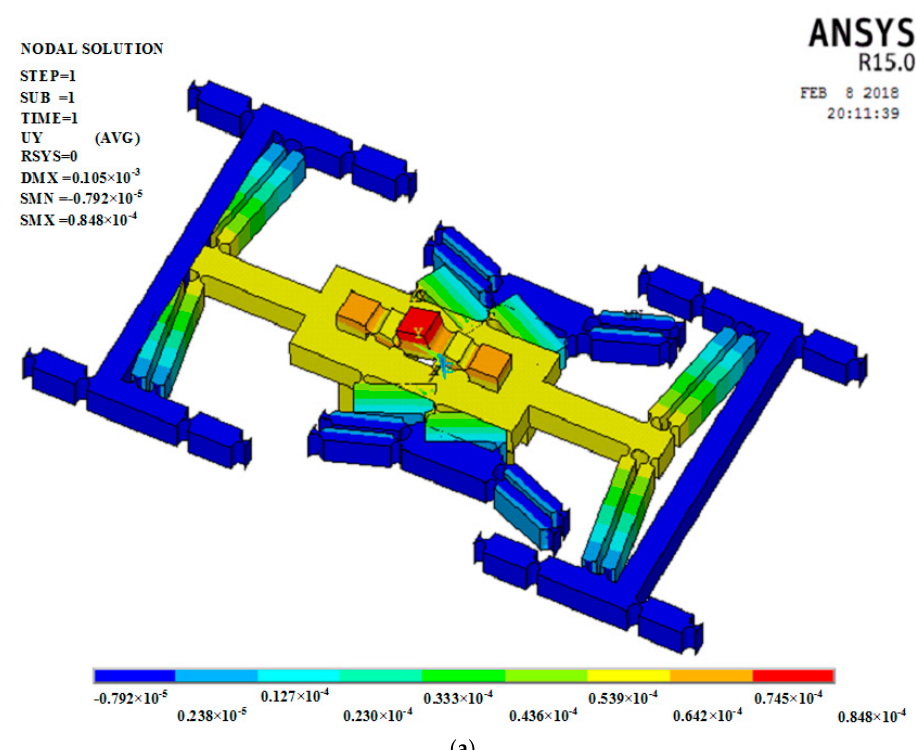
and FEA results are given in Table 1.